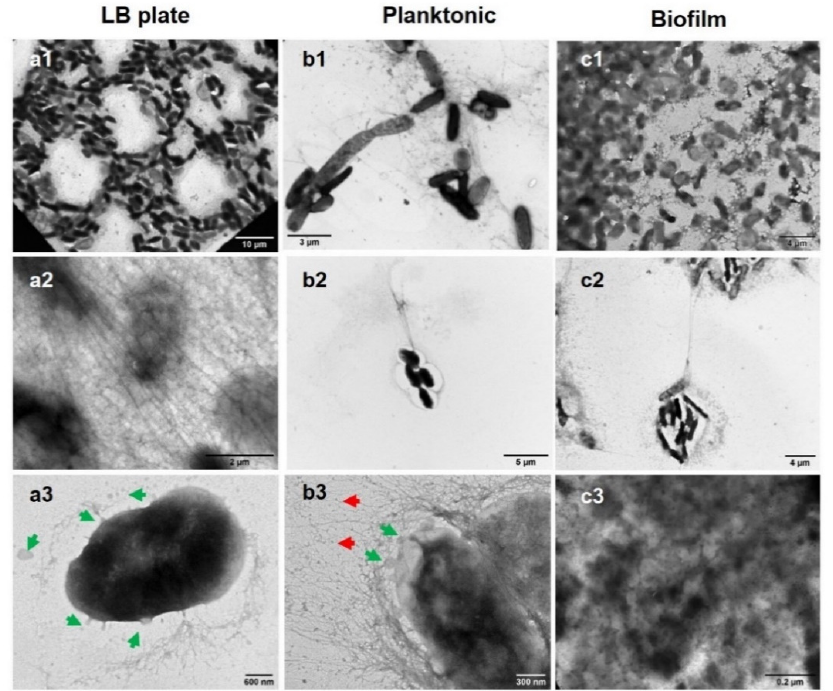
Figure 4. Ultrastructural analysis by TEM of the aggregation of CITA 33 strain in LB medium on petri plate in static conditions at 72 h growth ( a1 – a3 ). Progression of planktonic cells in LB liquid culture at 24 h ( b1 ) and 72 h growth ( b2 , b3 ). 48 h ( c1 , c2 ) and 72 h ( c3 ) mature biofilm.